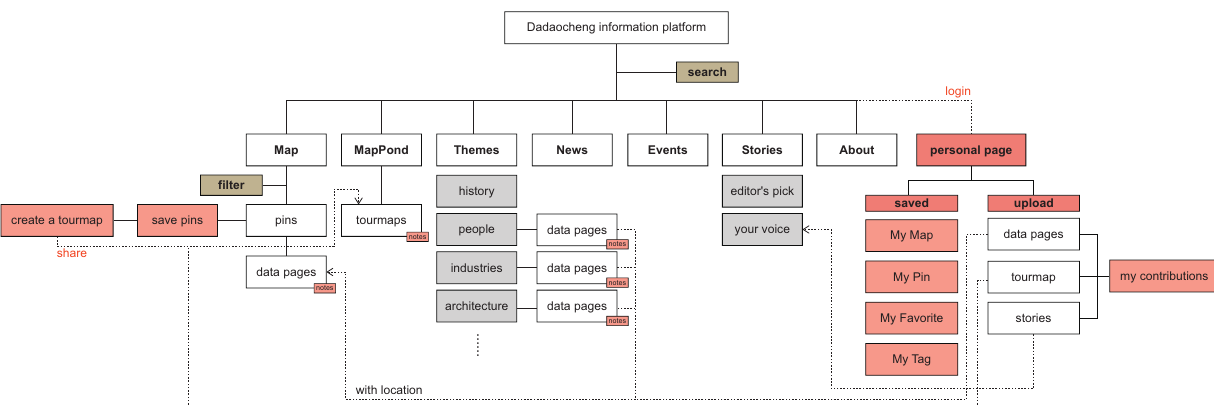
Figure 2. Overall structure.